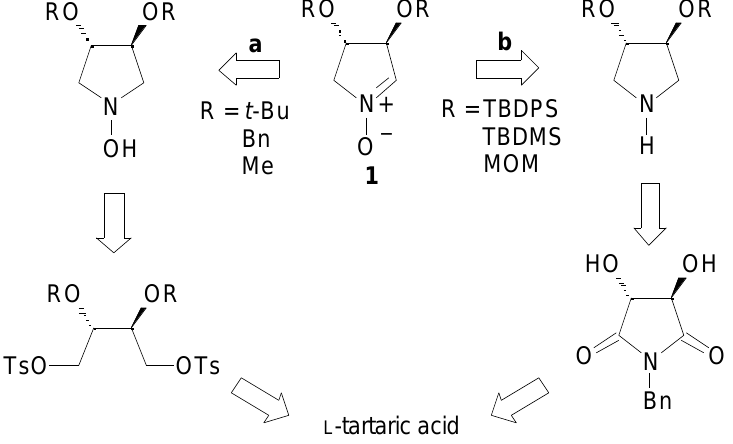
Scheme 1. Retrosynthetic schemes for tartaric acid derived nitrones 1